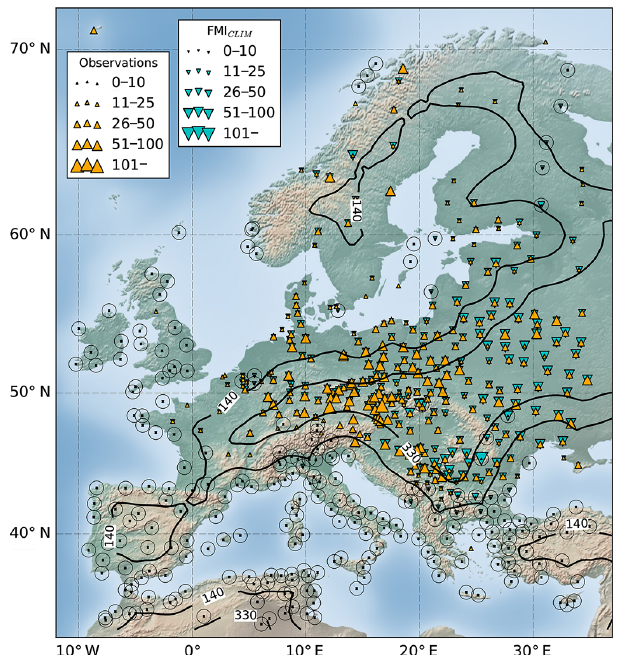
Figure 1. Total number of FZRA cases 1979–2014 in Europe ac- cording to 6h SYNOP observations (orange) and the FMI CLIM al- gorithm (cyan), applied to the 6h ERA-Interim reanalysis. The size of the markings indicates the frequency classes. The distance to the nearest coastline (in km) is shown with black isolines, which divide the stations into coastal, semi-coastal, and continental groups. Sta- tions that were excluded from the calibration, validation, and further analyses of the FMI CLIM algorithm are indicated with